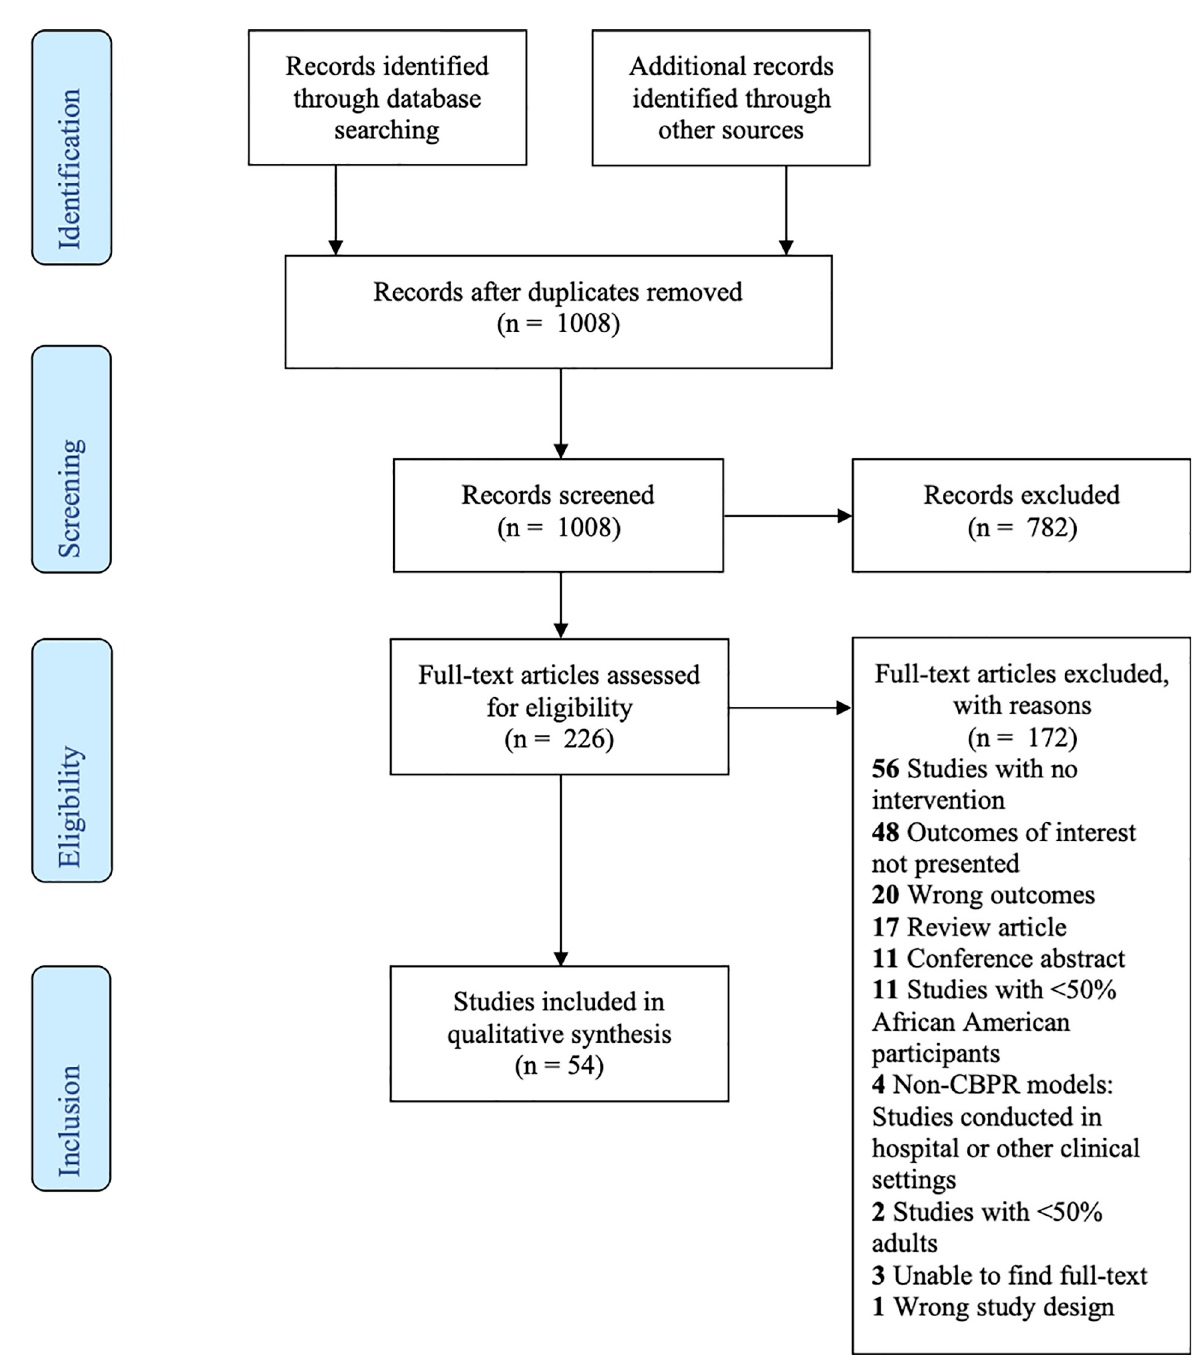
Fig 1. PRISMA flow diagram. No studies were specifically designed for African American men. Seven studies specifically tar- geted African American women [41–47]. Of the remaining 47 studies aimed at both African American men and women, 32 studies had females accounting for more than 70% of participants.